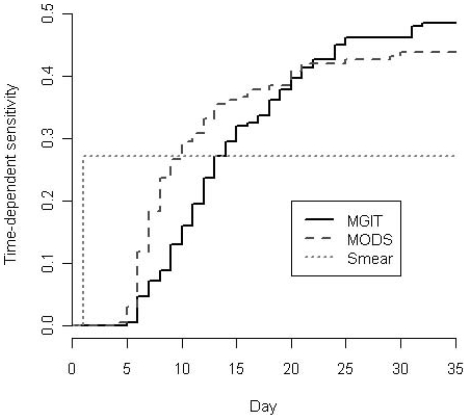
Time-dependent sensitivity of smear, MODS and MGIT.In the 73 samples which were both MGIT and MODS positive, the time dependent sensitivities of MODS were higher than MGIT on both day 7 (P<0.001) and day 14 (P = 0.04).